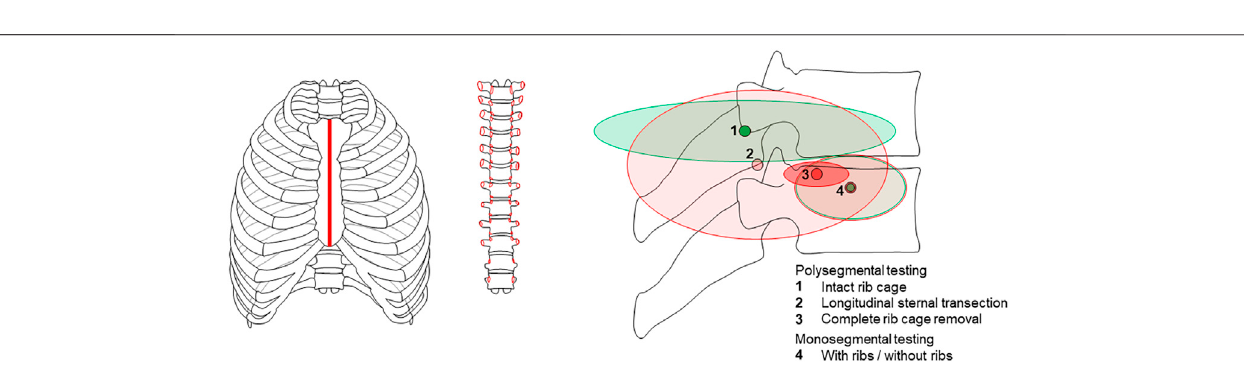
FIGURE5| Longitudinal sternaltransectionand complete rib cage removal. Thesagittalplane center ofrotationundergoesdisplacement in fl exion/extension after longitudinal sternal transection and complete rib cage removal in a polysegmental test setup according to Brasiliense et al. (2011) but not after complete rib removal in a monosegmental test setup according to Liebsch et al.